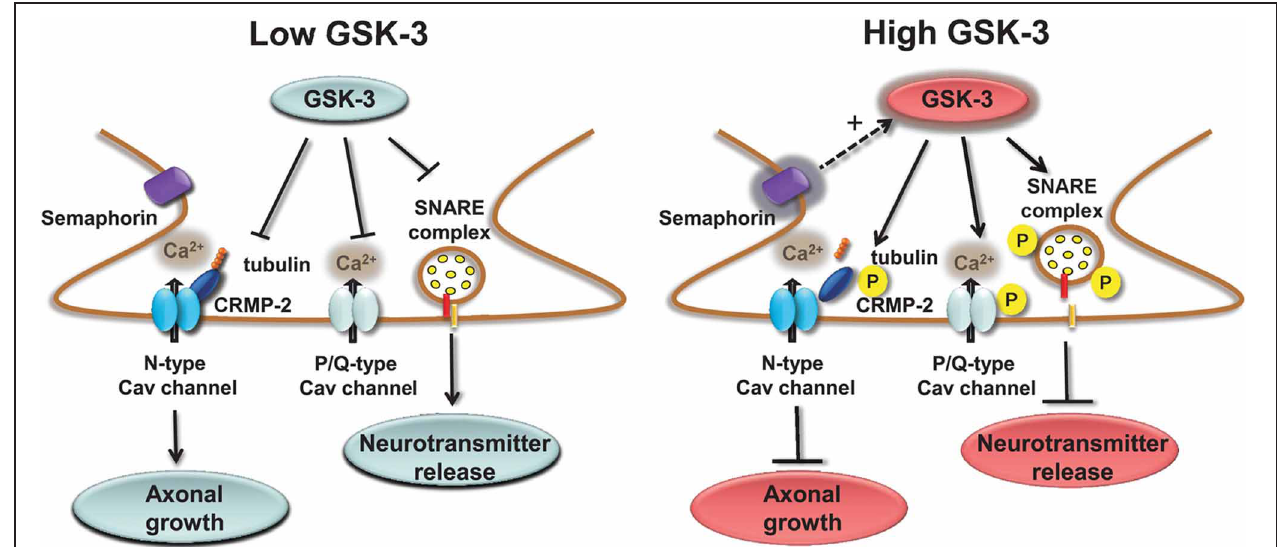
likewise, N-type Cav channel interaction with CPMP-2 is stabilized and axonal growth is stimulated. Opposite effects are expected upon high levels of GSK-3 induced, for example, by stimulation of semaphorin 3A signaling